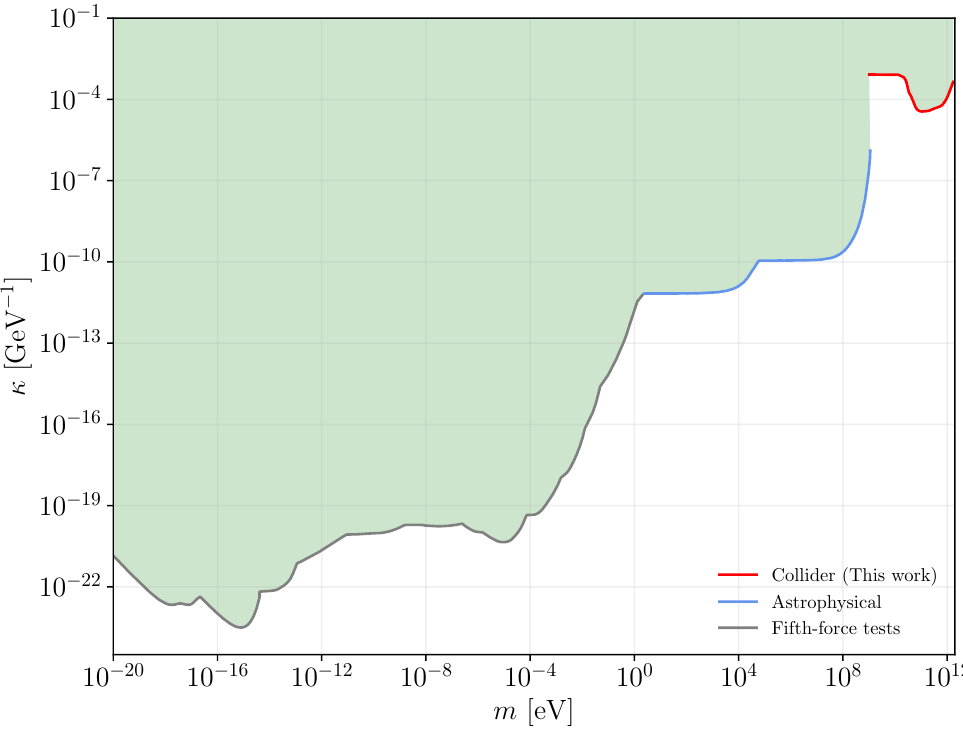
Figure 3. Total constraints in the hidden-graviton parameter space. The shaded region is excluded. “Fifth-force tests” represents a collection of laboratory and Solar System experiments, see [25] and references therein. The astrophysical bounds were derived in [25], based on stellar energy-loss arguments. “Collider” represents the combined bounds from figures 1 and